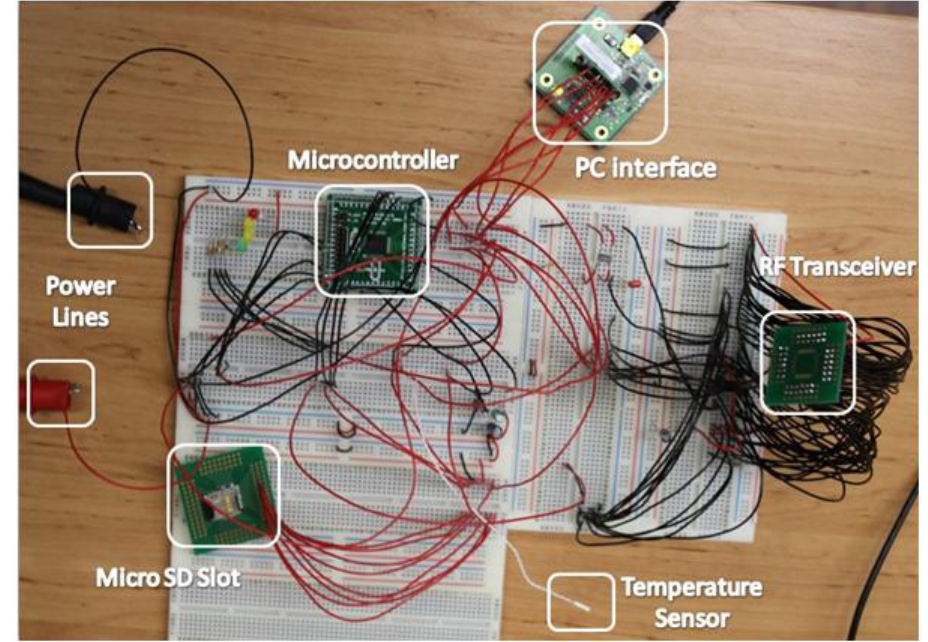
Figure 4. Physical testbed for performance evaluation and validation of the proposed temperature